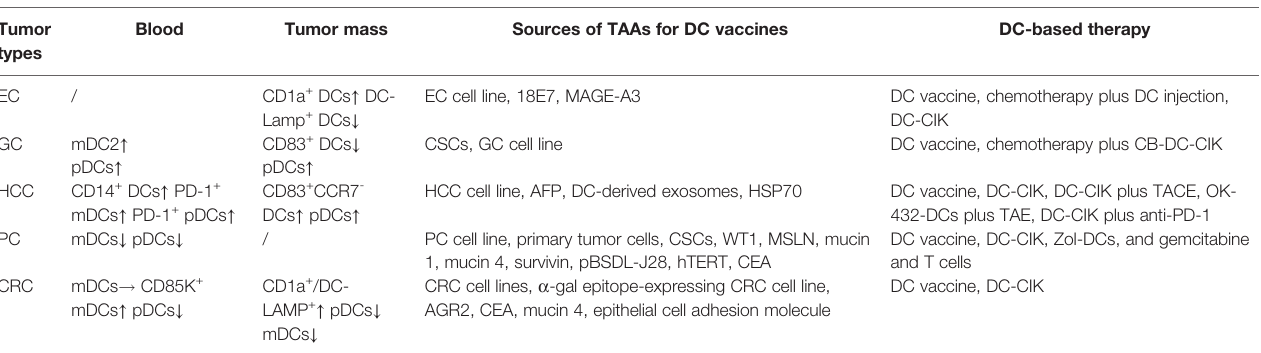
TABLE 1 | Summary of DC subsets and TAAs in GI cancer.